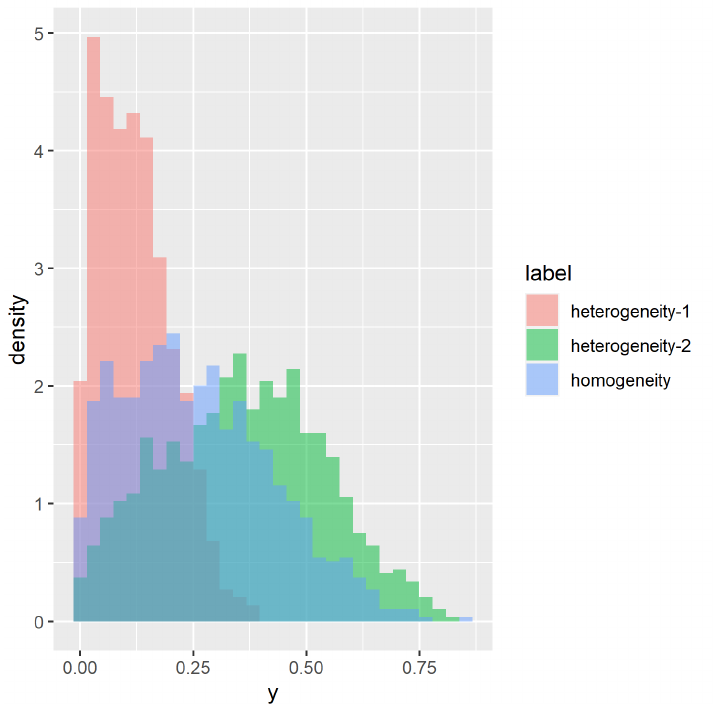
Figure 1. The histograms based on a homogeneous-Gompertz data set and two heterogeneous- Gompertz data